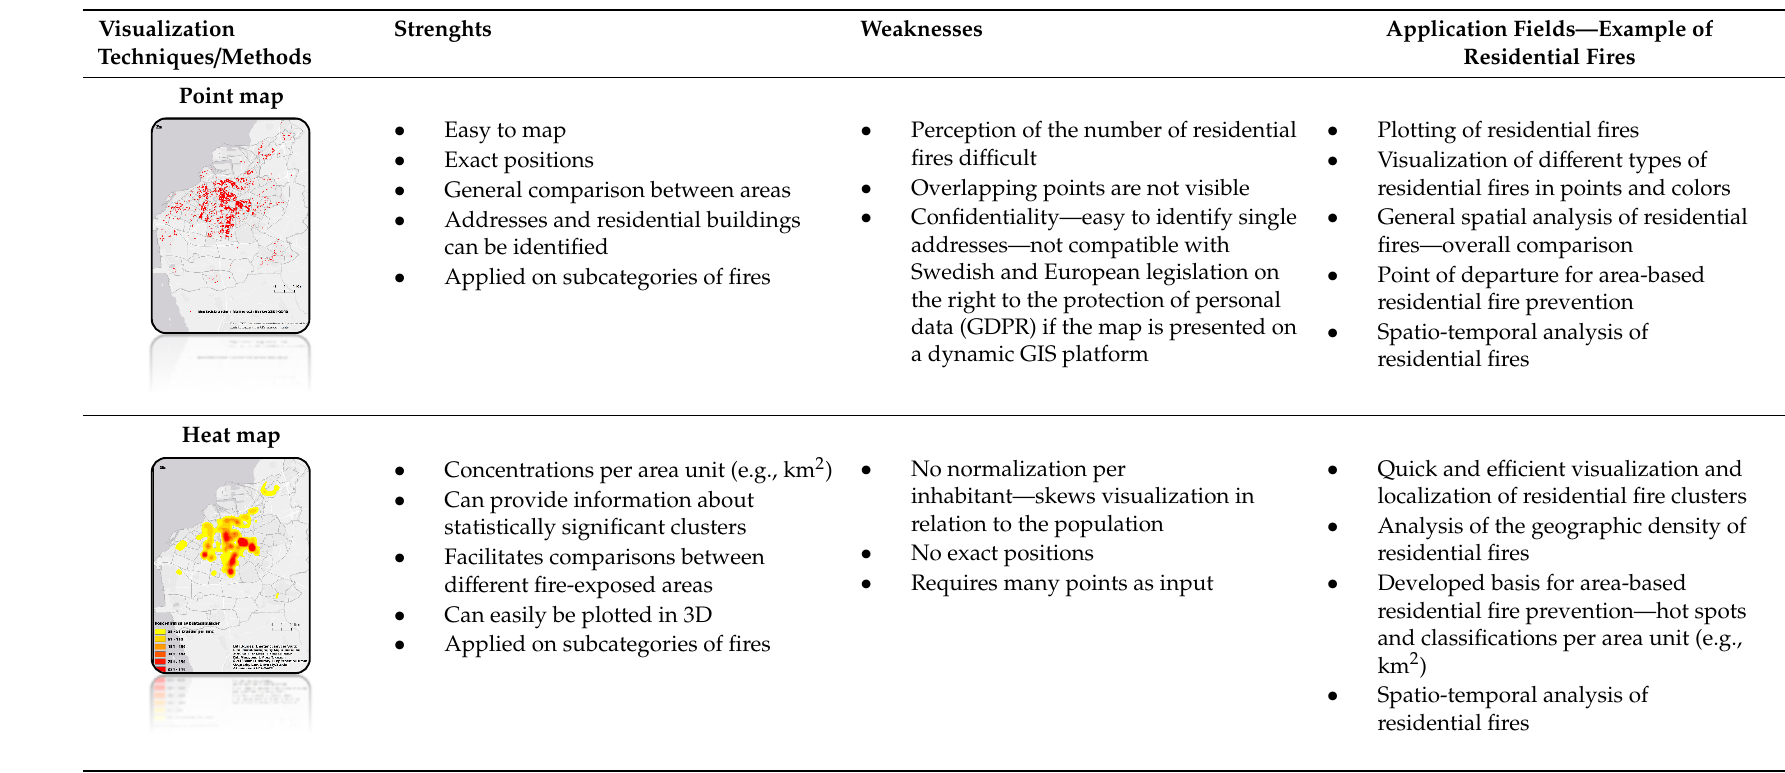
Table 3. Strengths and weaknesses of the visualization methods, and possible fields for spatial application of residential fires.